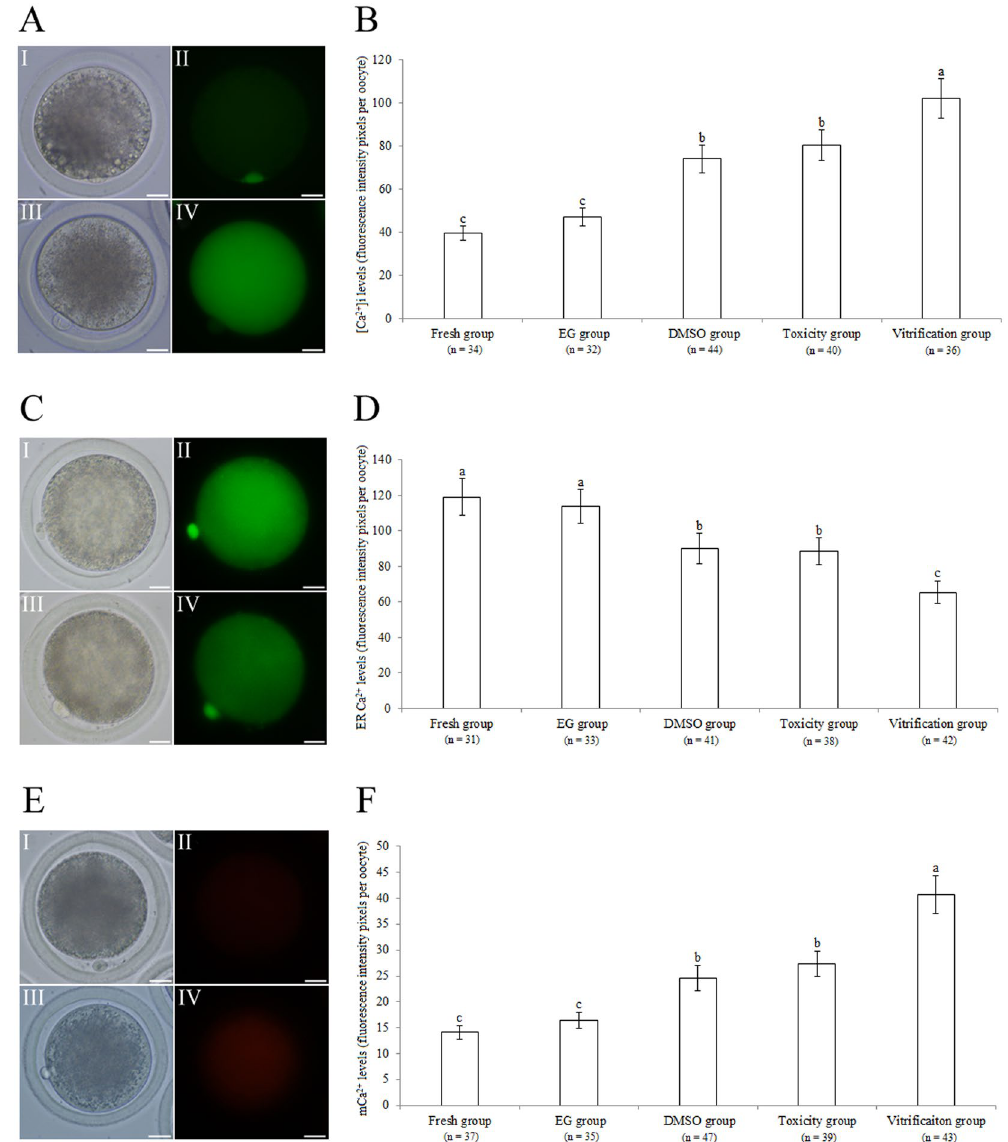
Figure 1. Effect of vitrification on the Ca 2 + levels of bovine oocytes. ( A , C , E ) Bovine oocytes stained with [Ca 2 + ]i, ER Ca 2 + , and mCa 2 + detection kits. (I, II) oocytes from the fresh group. (III, IV) oocytes from the vitrification group. Scale bar = 20 μ m. ( B , D , F ) [Ca 2 + ]i, ER Ca 2 + , and mCa 2 + levels in bovine oocytes, respectively. a,b,c : Values with different superscripts differ significantly between groups ( P <